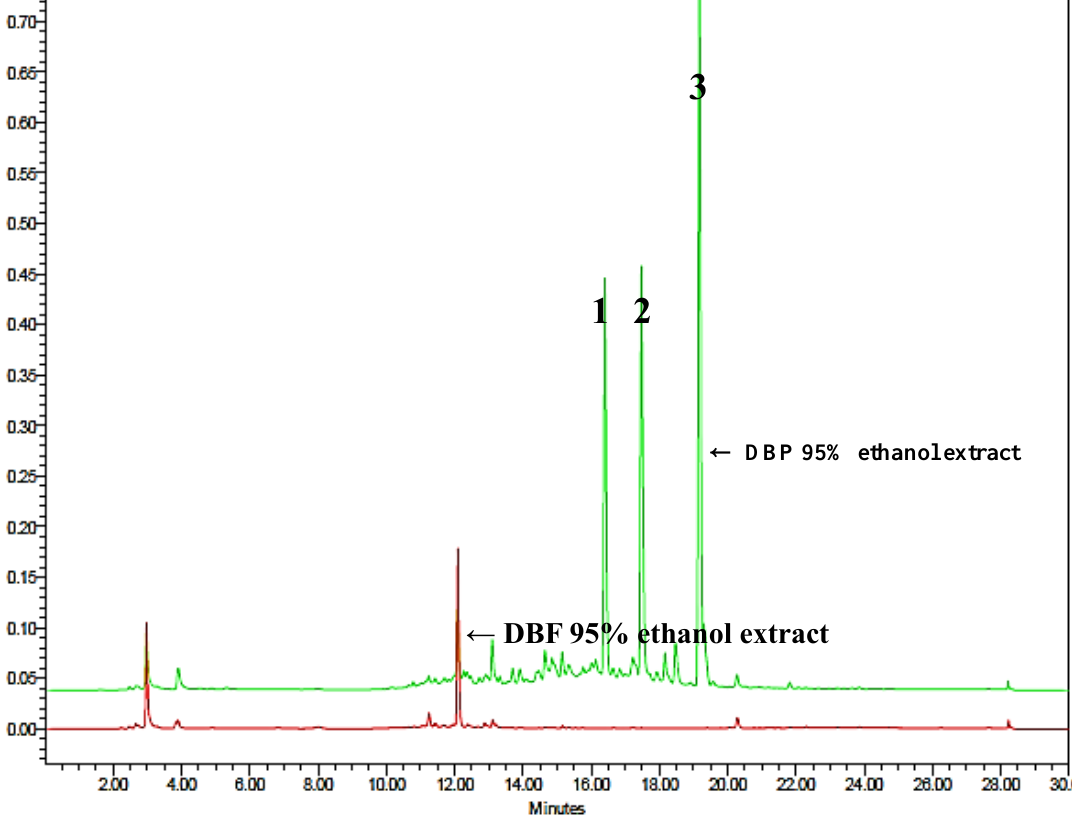
Figure 2. HPLC chromatogram of the Dioscorea batatas flesh (DBF) (red) and the D. batatas peel (DBP) (green) extracts monitored at the wavelength of 260 nm.